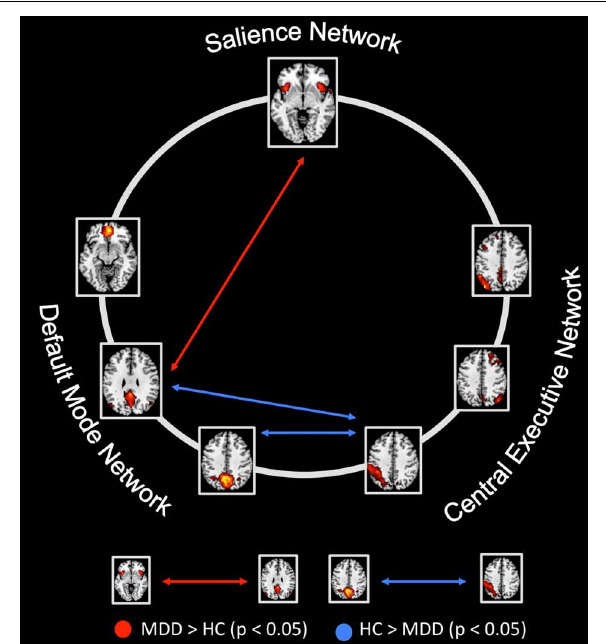
FIGURE 4 | Between-group differences of inter-network intrinsic functional connectivity. Based on network time courses, inter-network intrinsic functional connectivity (inter-iFC) was calculated by the use of Pearson’s correlation between subject specific ICN timecourses (TCs). The red arrows indicates increased inter-iFC in patients with major depressive disorder compared to healthy controls (two-sample t -test, p < 0 . 05, Bonferroni-corrected for multiple comparisons); The blue arrows indicates decreased inter-iFC in patients with major depressive disorder compared to healthy controls (two-sample t -test, p < 0 . 05, Bonferroni-corrected for multiple comparisons). Spatial maps indicate the anterior/inferior-posterior/superior-posterior default mode network (a/ip/spDMN), left-ventral/right-ventral/dorsal central executive network (lv/rv/dCEN), and salience network (SN). All tests were corrected for age, sex, and GM volume of the brain areas covered by the 7 networks of interest. Abbreviations: MDD, group of patients with major depressive disorder; HC, healthy control group (see also Table 4 ).